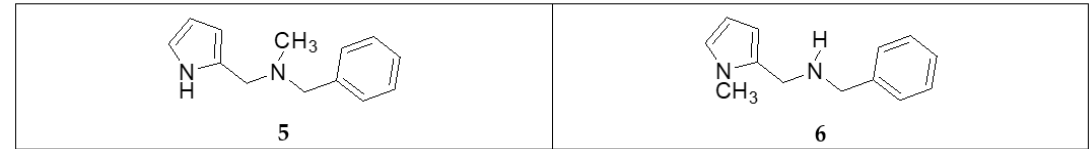
Figure 4. The structure of pyrrole derivatives; compounds 5 and 6 represent MAO-B and MAO-A selective inhibitors, respectively.